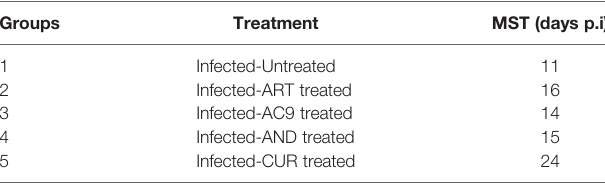
The fi rstgroupwastreatedorallyfor4dayswith200 m LPBSpermicefromday6today9 p.i.Thesecond,third,fourthand fi fthgroupsweretreatedwith50mg/kgbodyweightART per mice, 50 mg/kg body weight AC9, 50 mg/kg body weight AND and 50 mg/kg body weight CURrespectively, orally in200 m L PBS,from day6 today9 p.i.Thesurvival period for all the groups was recorded and MST from 6 mice per group was